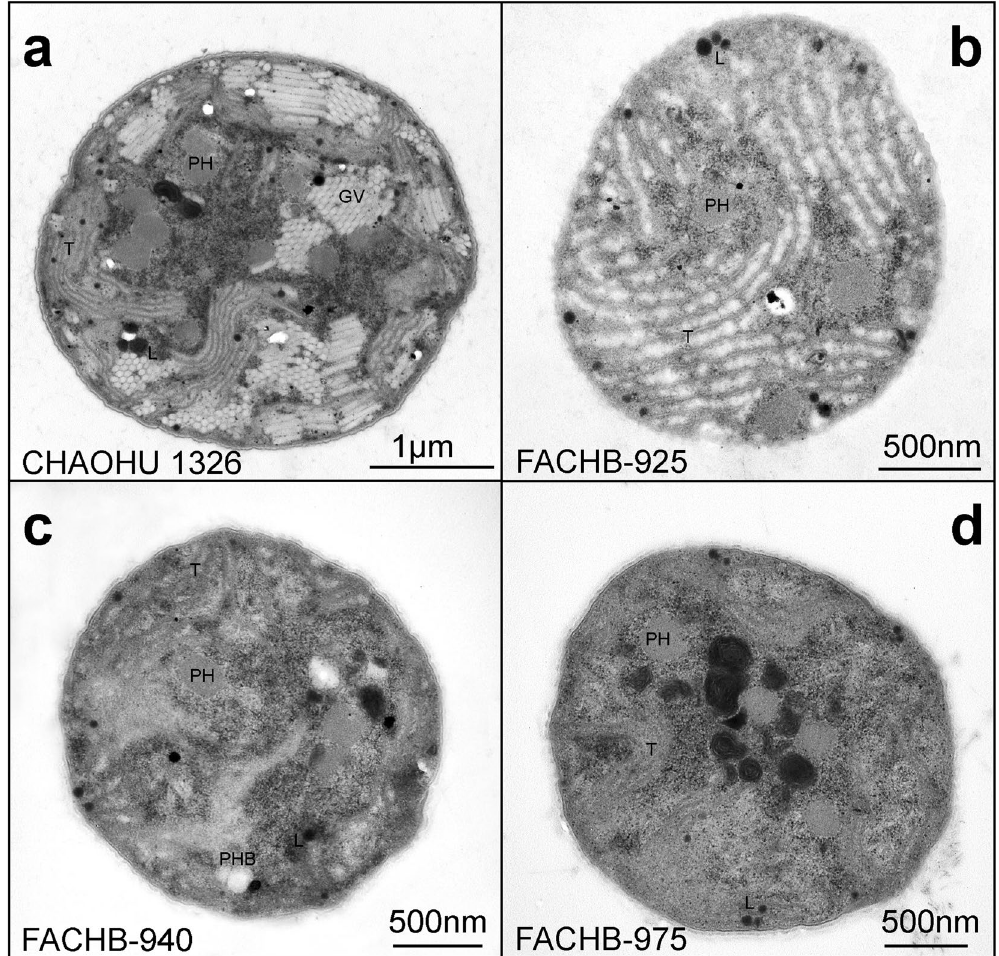
Figure 4. TEM images of the four M. aeruginosa strains at mid-exponential growth phase in BG11 medium, including strains CHAOHU 1326 ( a ), FACHB-925 ( b ), FACHB-940 ( c ), and FACHB-975 ( d ). Poly-beta- hydroxybutyrate (PHB), poly granules (PH), lipid droplets (L), thylakoids (T), and gas vesicles (GV) are